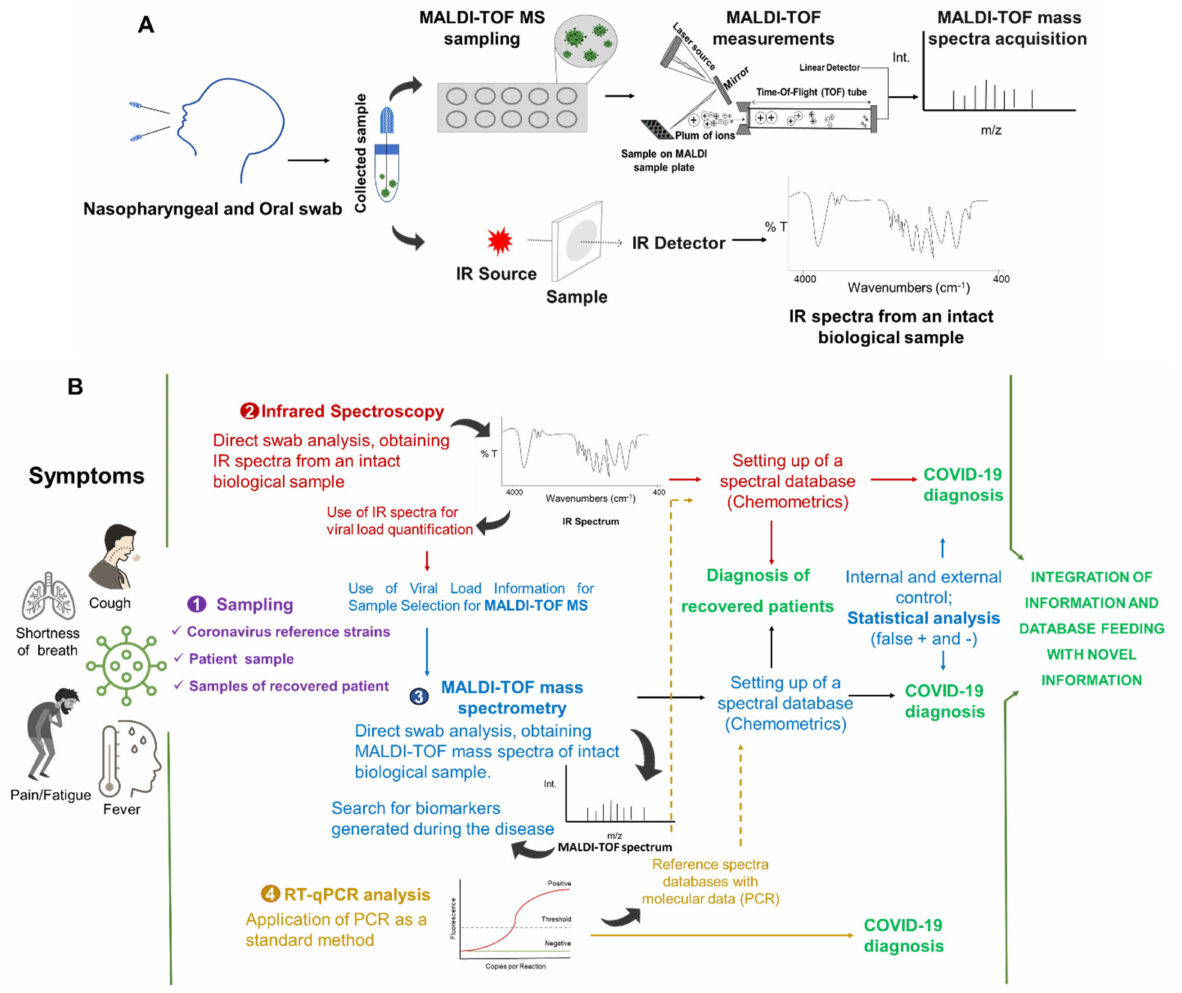
Figure 3. Integrated analytical platform based on IR spectroscopy, MALDI-TOF MS, and RT-qPCR for SARS-COV-2 detection and quantification and COVID-19 fast diagnosis. ( A ) General procedure for nasopharyngeal and oral swab sampling and spectral acquisition. ( B ) Way for integration of information and database feeding with novel information. RT-qPCR is the gold standard of the proposed analytical